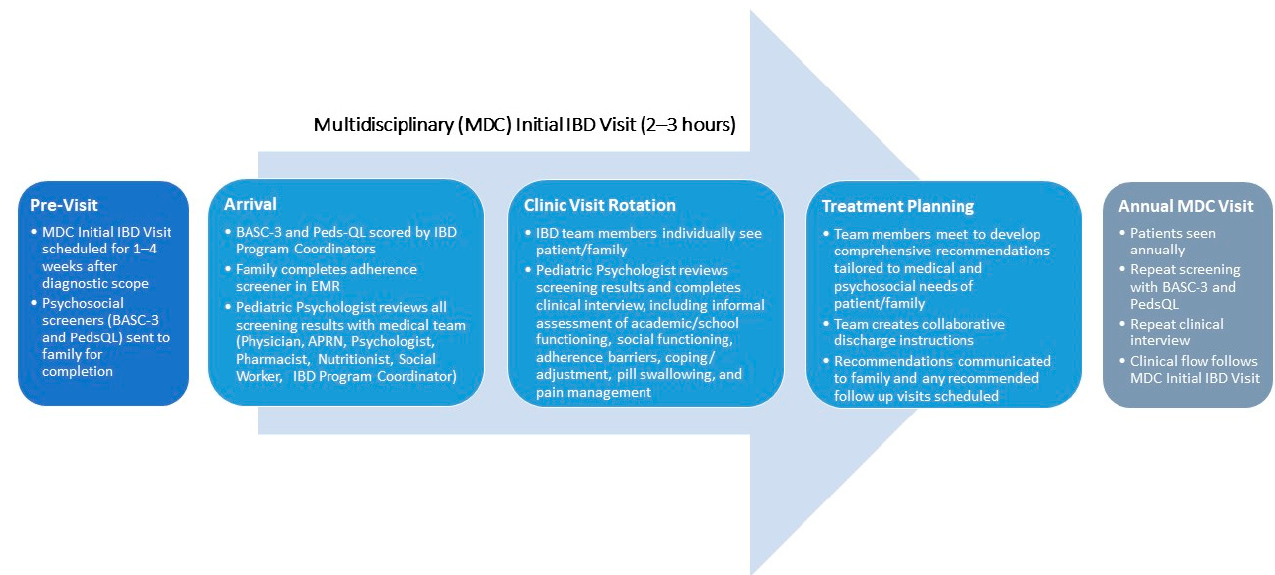
Figure 1. Sample flow diagram with inclusion of screening process for new patient integrated care clinic for pediatric inflammatory bowel disease (IBD). MDC: multidisciplinary clinic; APRN: advanced practice nurse; EMR: electronic medical record. Screening measures referenced above: BASC-3, Behavioral Assessment System for Children–Third Edition [25]; Peds-QL, Pediatric Quality of Life Inventory 4.0 Generic Core Scales [26]. For more information on this clinic and the screening process/questions used, please see Maddux and colleagues [27].